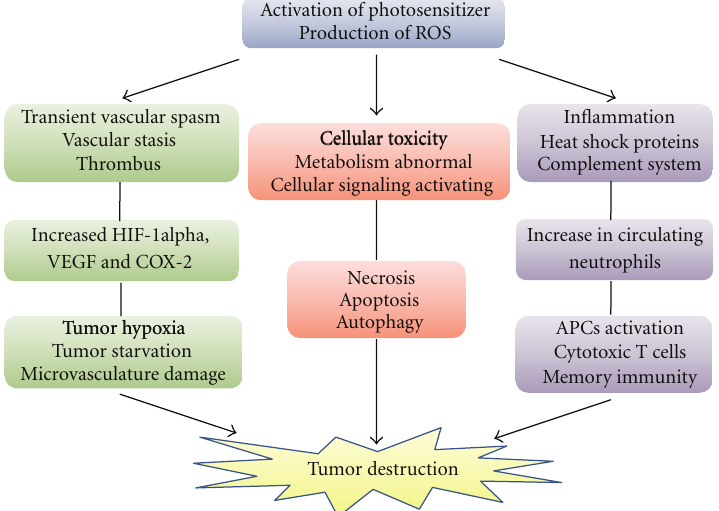
Figure 5: Pathways of PDT-induced pancreatic tumor cell death or destruction. The antitumor e ff ects of PDT include three main mechanisms: direct tumor cell killing, vascular destruction, and immune system